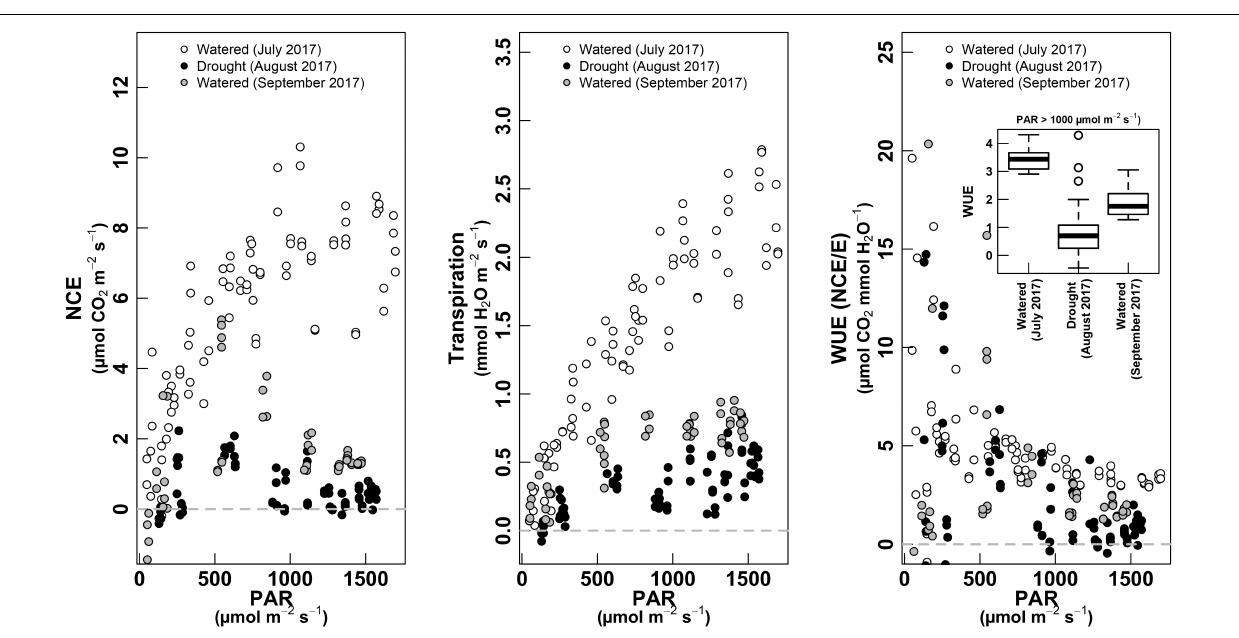
FIGURE 6 | PAR response curves for NCE—whole-plant net carbon exchange (left panel, µ mol m − 2 s − 1 ), whole-plant Transpiration (middle panel, mmol m − 2 s − 1 ) and WUE as NCE/E (right panel, µ mol CO 2 mmol − 1 H 2 O). The relationship is shown for the three water treatments: white dots for “Watered” (measured in July 2017); black dots for “Drought” (measured in August 2017); gray dots for “Watered” (measured in September 2017). The boxplot inset in the right panel shows values of WUE for each treatment when PAR is > 1,000 µ mol m − 2 s − 1 . Only data with PAR > 50 µ mol m − 2 s − 1 are